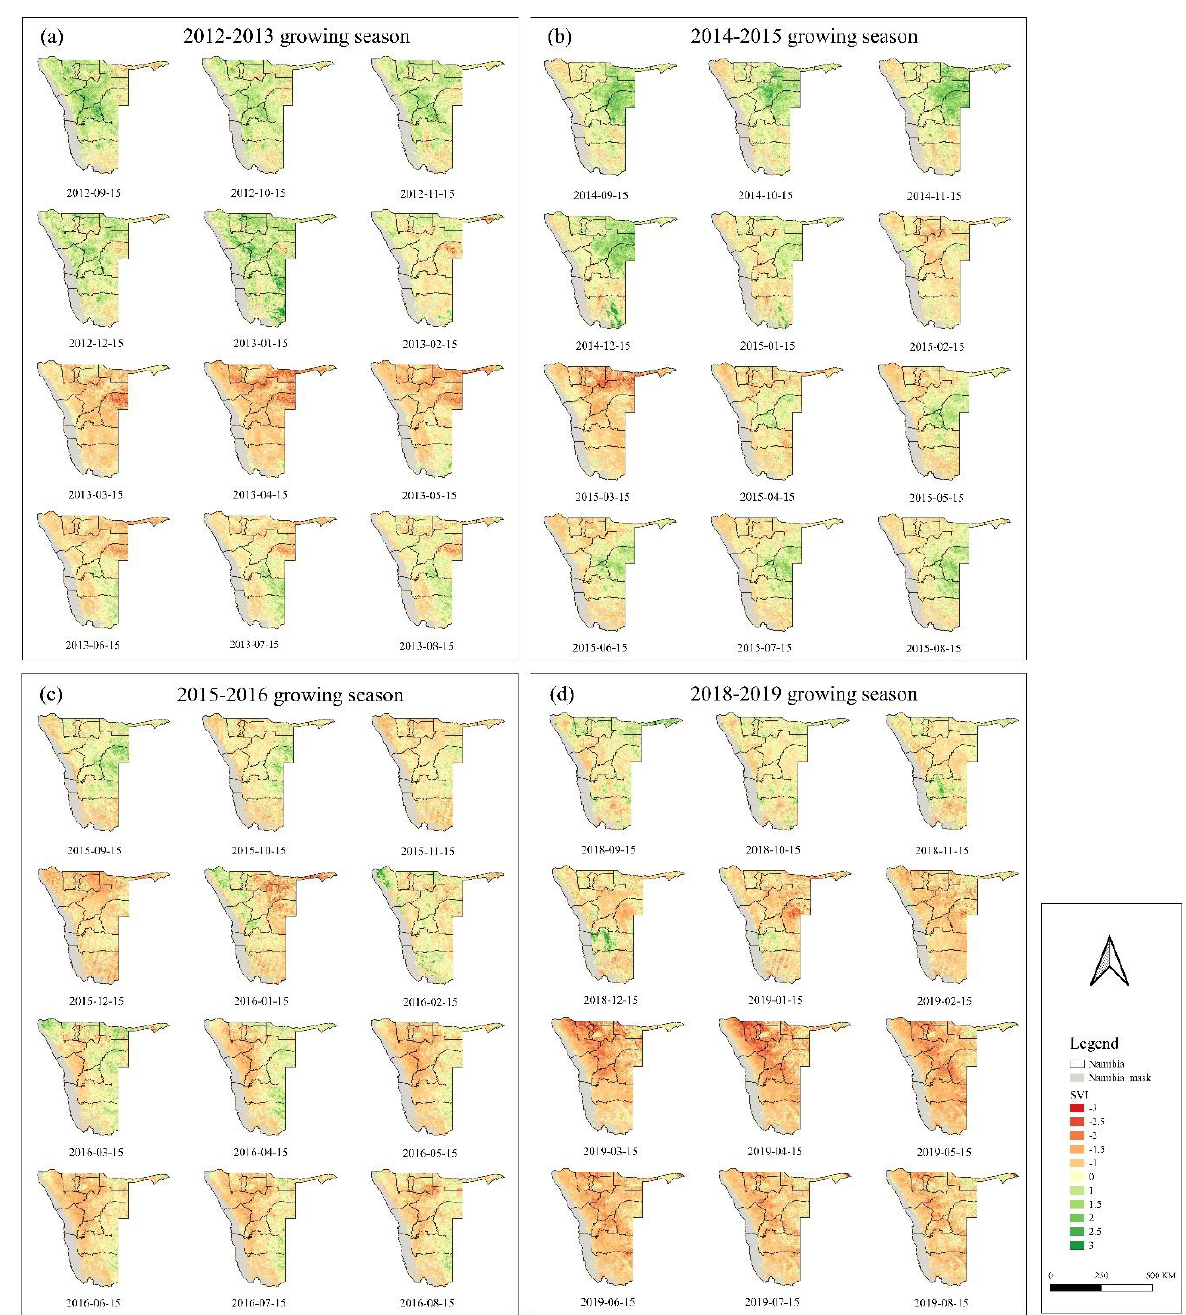
Figure 6. Spatiotemporal dynamics of SVI (one-month): ( a ) SVI in the 2012–2013 growing season; ( b ) SVI in the 2014–2015 growing season; ( c ) SVI in the 2015–2016 growing season; ( d ) SVI in the 2018–2019 growing season.